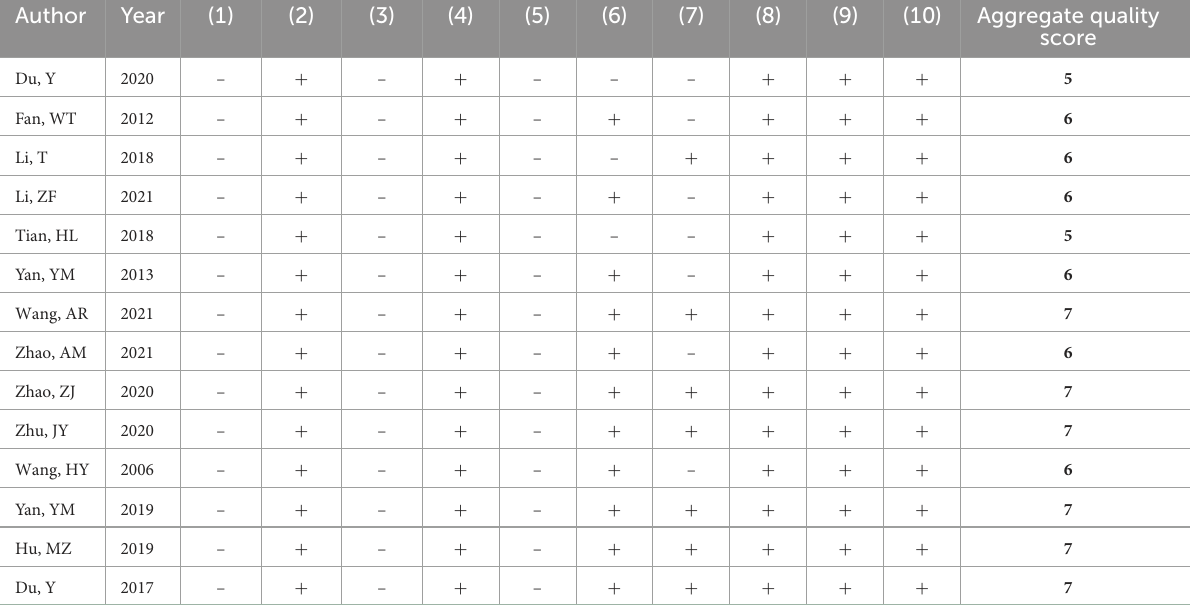
TABLE 2 Study quality score